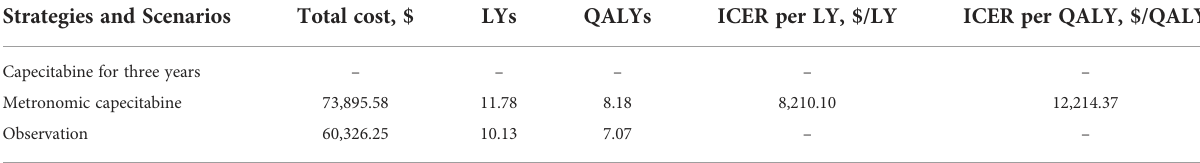
TABLE 4 Results of structural sensitivity analysis. Strategies and Scenarios